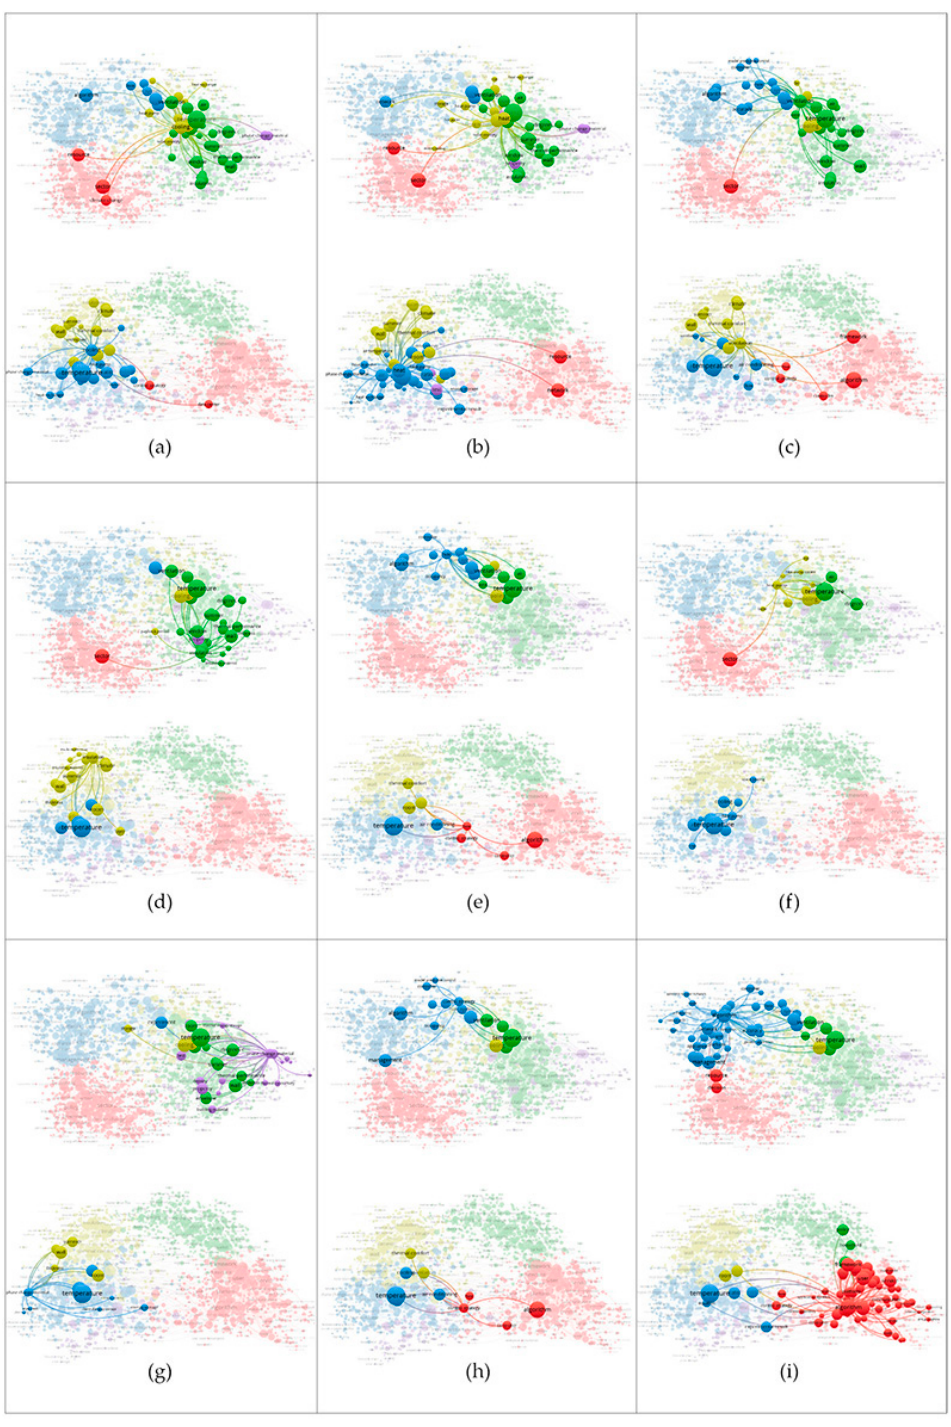
Figure 14. Detail of the co-occurrence keywords (left: Web of Science, and right: Scopus): ( a ) links of the term “cooling”; ( b ) links of the term “heating”; ( c ) links of the term “ventilation”; ( d ) links of the term “insulation”; ( e ) links of the terms “HVAC” and “HVAC system”; ( f ) links of the term “heat pump”; ( g ) links of the term “phase change material”; ( h ) links of the term “control strategies”; and ( i ) links of the term “algorithm”.